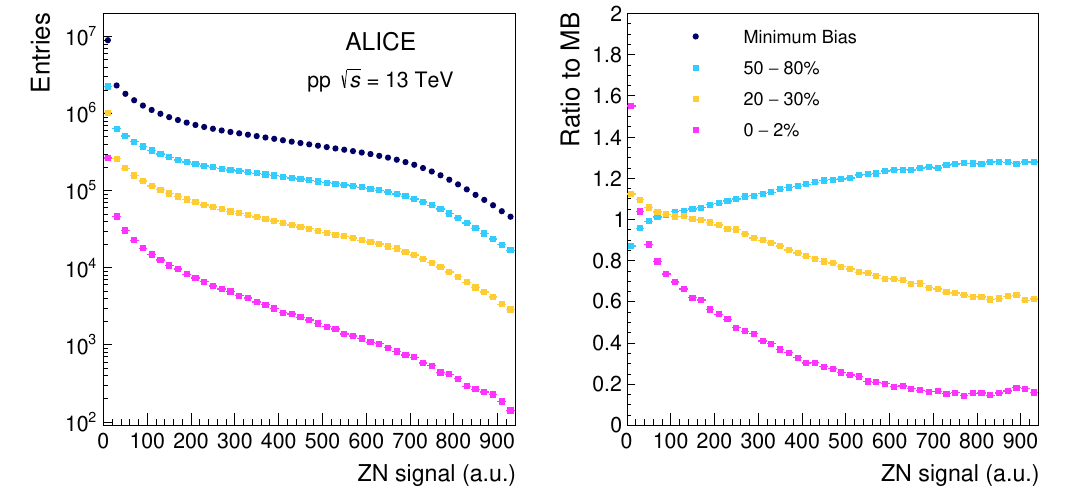
√ Figure 8 . Left: ZN spectrum in pp collisions at s = 13 TeV for the MB sample (blue circles) and in three multiplicity intervals: high (magenta squares), intermediate (orange squares) and low (azure squares) multiplicity. Right: ratio of the spectra, normalised to the number of events in each bin, in the three multiplicity intervals to the MB